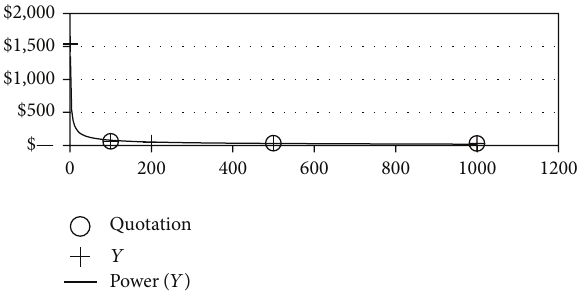
Figure 3: Graph of quotation price versus learning model price for